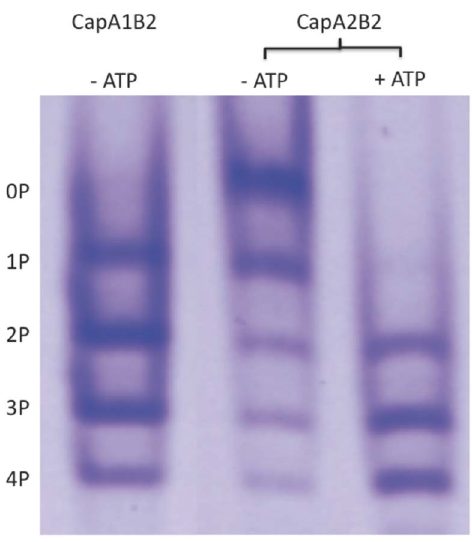
Figure 3. CapA2B2 phosphorylation state analysis. Electropho- retic profile of CapA1B2 and CapA2B2 directly after purification ( 2 ATP) or after 4h incubation at 37 u C with 200 m M ATP-Mg ( + ATP). The proteins were loaded on a 12.5% non-denaturing polyacrylamide gel and stained with Coomassie Brilliant Blue. The five observed bands were labeled according to the mass spectrometry analysis previously performed on CapA1B2 [16]: the upper band corresponds to the non- phosphorylated form of the protein (0P), and the lower band to the fully phosphorylated form (4P).